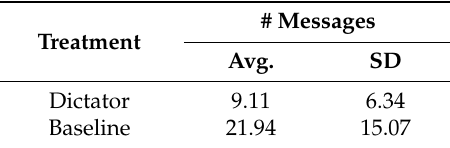
Table 3. Number of messages in chat protocol per treatment.